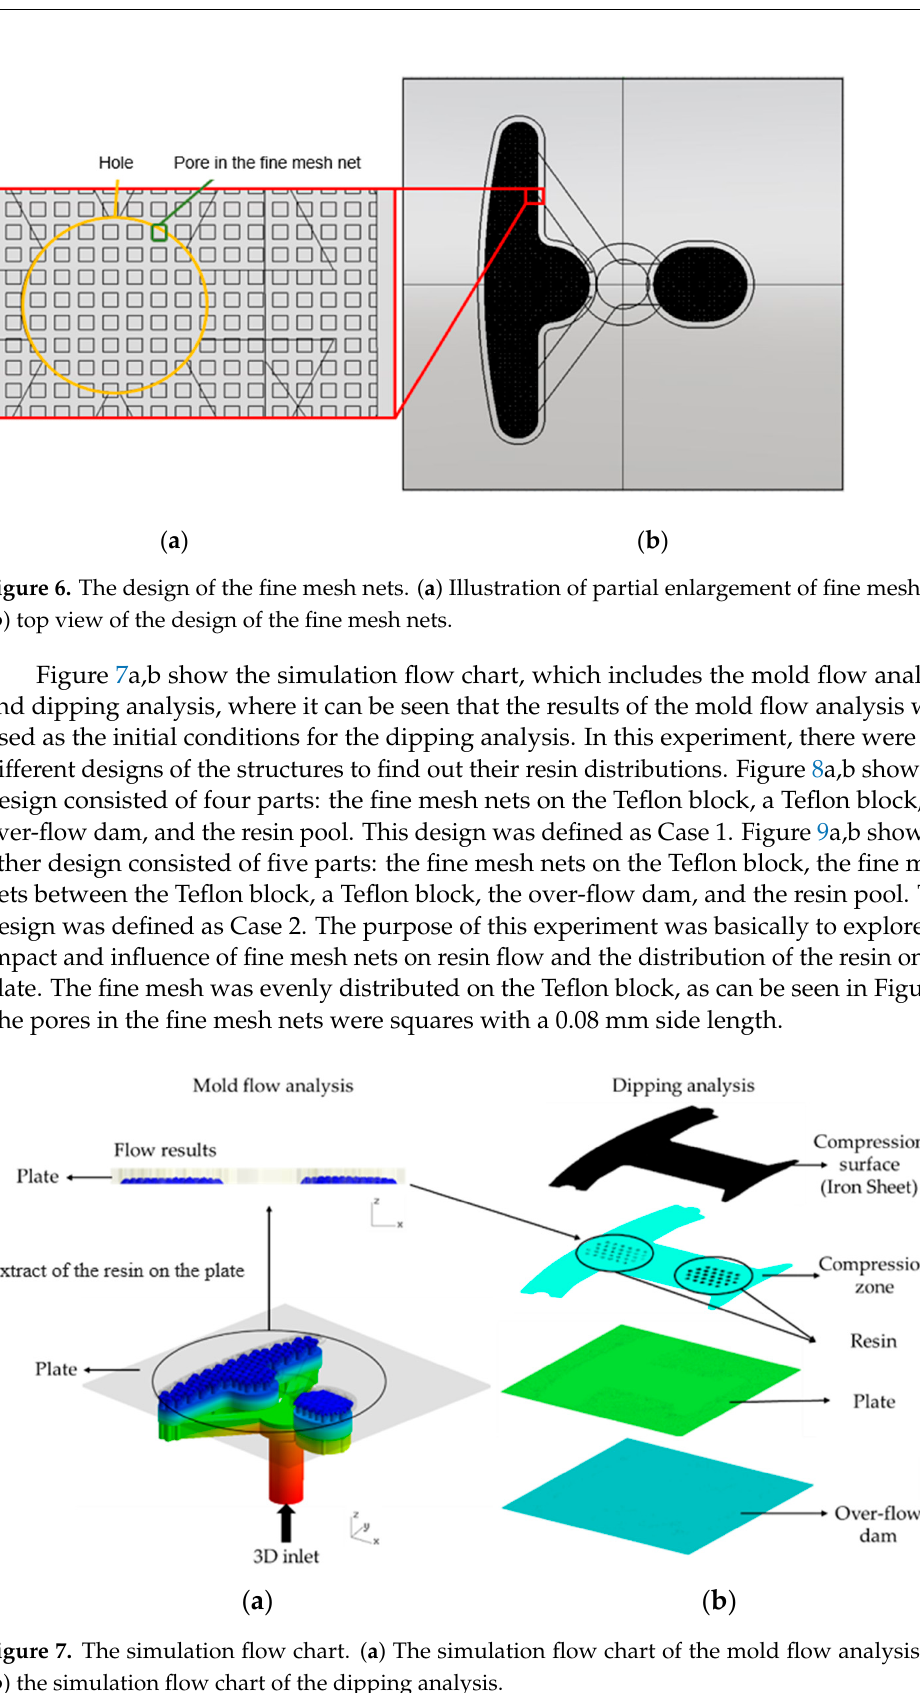
Figure 5. The design of the Teflon module. ( a ) Top view of the Teflon block; ( b ) bottom view of the Teflon block; and ( c ) the microstructure of the Teflon block.